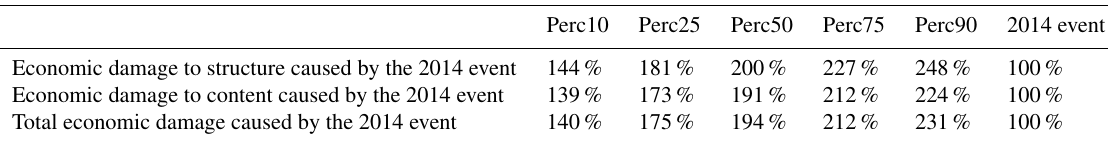
Table 3. Ratio between damage estimated for the considered flooding scenarios and damage estimated for the event on 9 October 2014. Perc10 Perc25 Perc50 Perc75 Perc90 2014 event Economic damage to structure caused by the 2014 event 144% 181% 200% 227% 248% 100% Economic damage to content caused by the 2014 event 139% 173% 191% 212% 100% Total economic damage caused by the 2014 event